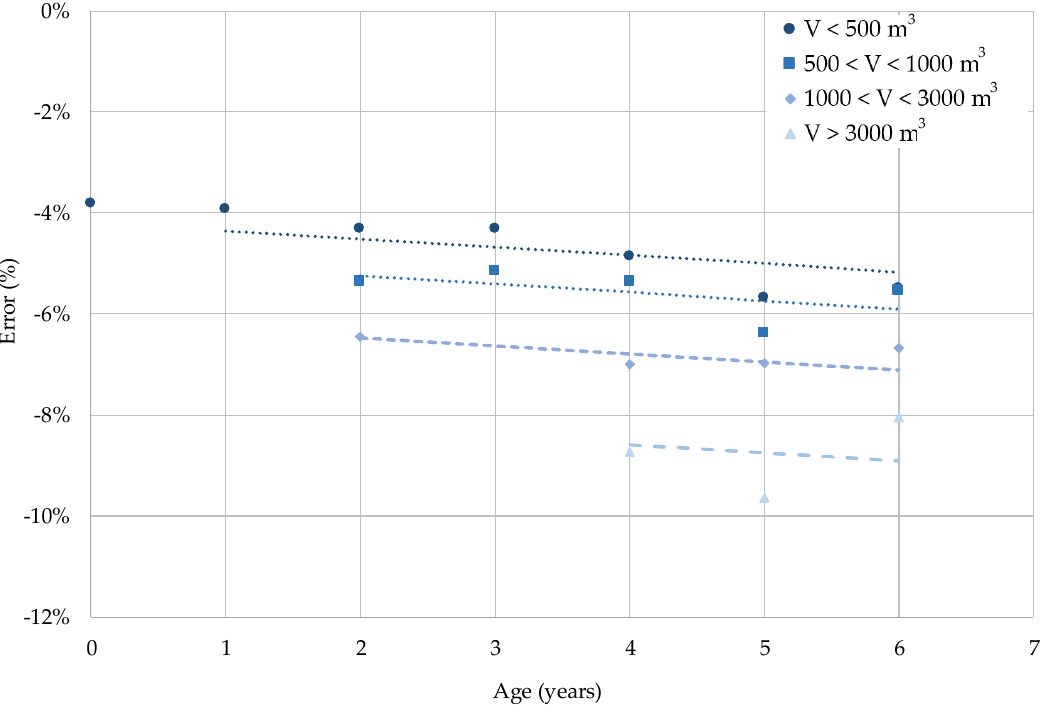
Figure 5. The degradation rate of the weighted error with age and totalised volume (meter M_1).